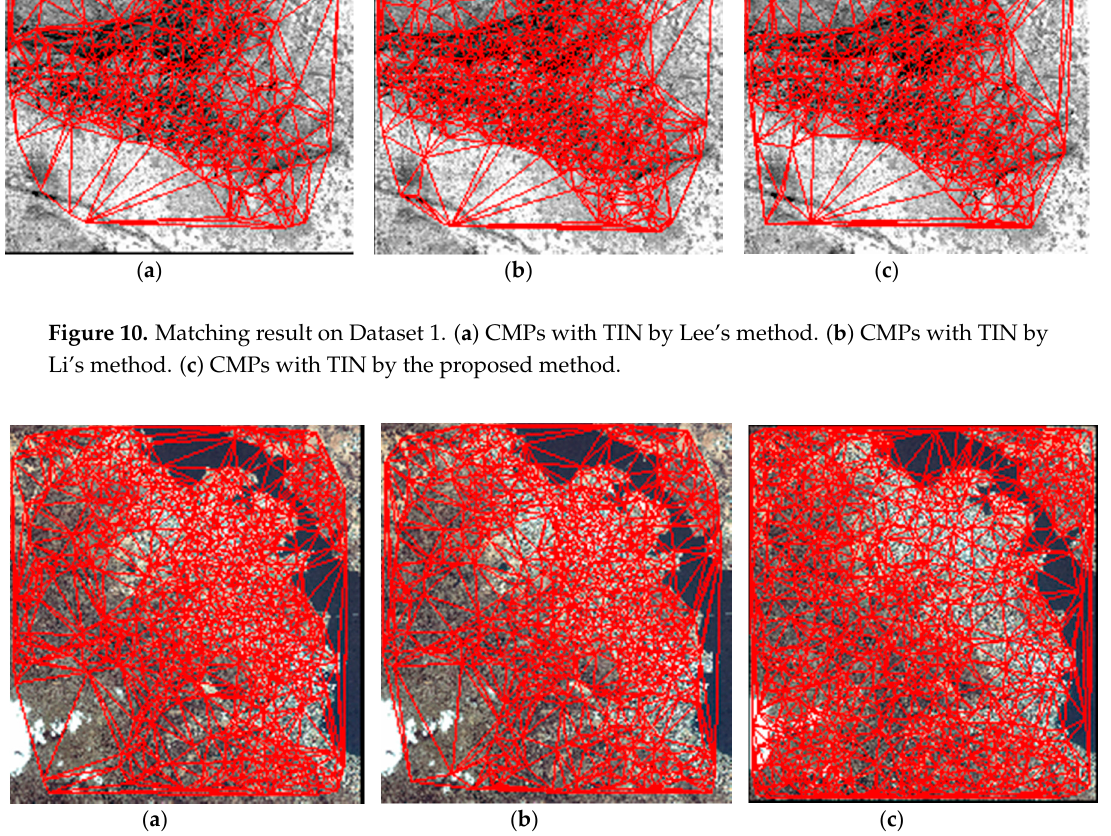
Figure 11. Matching result on Dataset 2. ( a ) CMPs with TIN by Lee’s method. ( b ) CMPs with TIN by Li’s method. ( c ) CMPs with TIN by the proposed method.